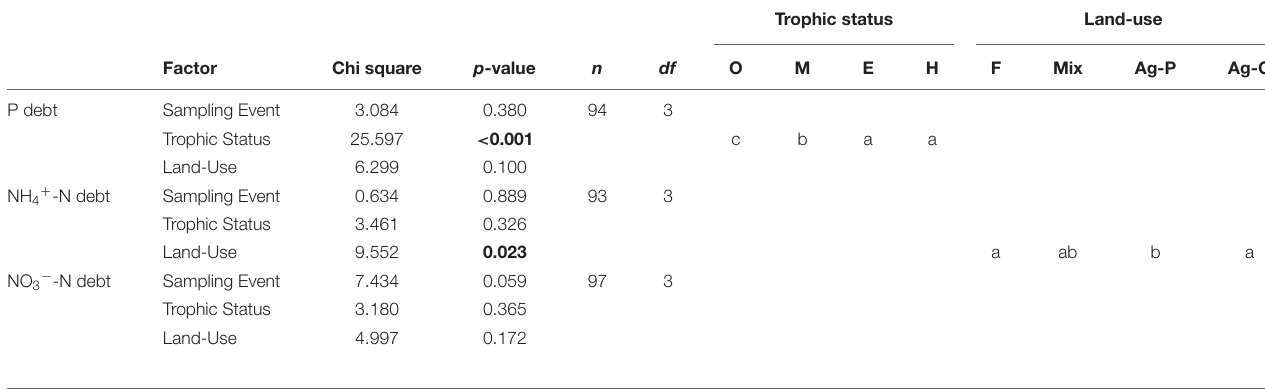
TABLE 7 | A Kruskal Wallis ANOVA was conducted on the 2018 nutrient debts (P debt, NH 4 + -N debt, NO 3 − -N debt) to test for the effects of sampling event, trophic status, and watershed land-use.